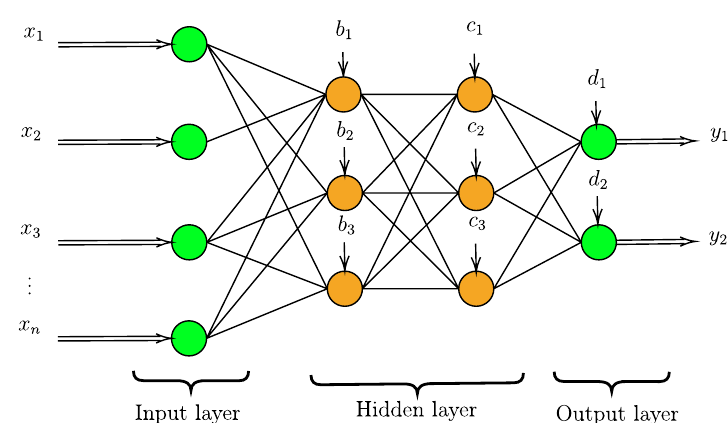
Fig. 10 Multilayer neural network basic structure